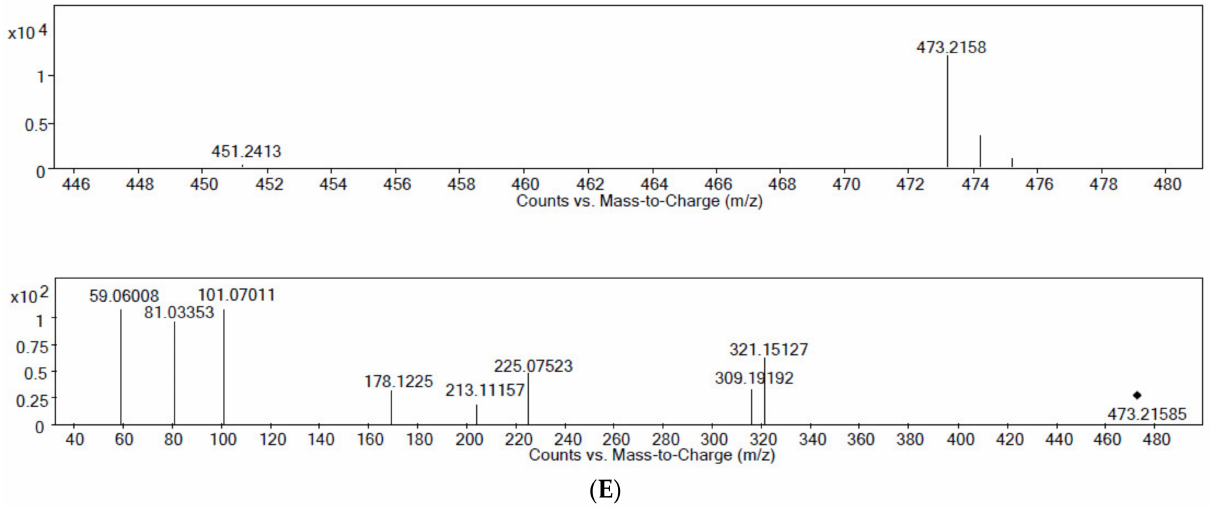
Figure 4. MS and MSMS spectrum of ( A ) Alcohols Dehydration (M1), ( B ) Demethylation metabolites (M2), ( C ) Demethylation + Hydrogenation metabolites (M3), ( D ) 2 × Hydroxylation metabolites (M4), ( E ) Demethylation and two Hydroxylations (M5) metabolite using an ultra-high performance